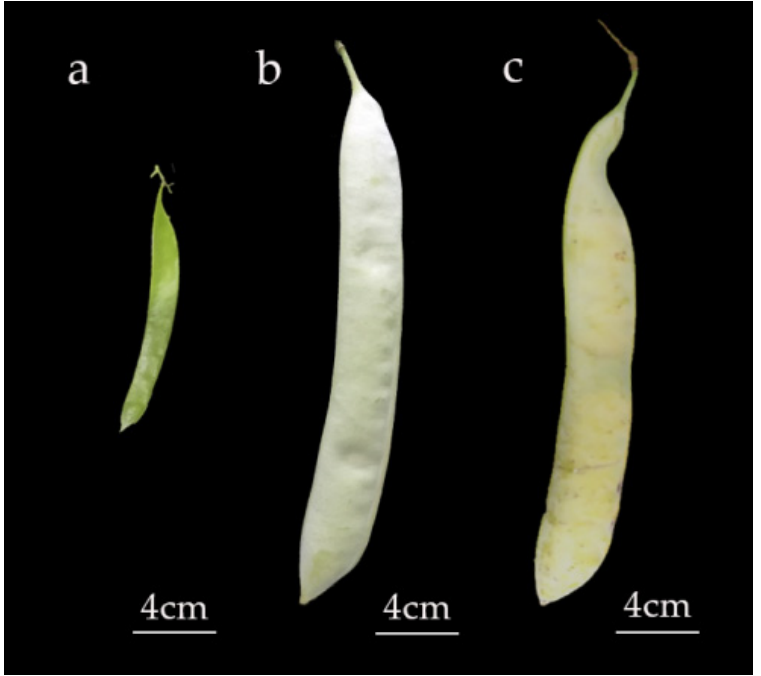
Figure 1. Gleditsia sinensis pods at the fruit-setting stage ( a ), elongation stage, ( b ) and browning stage ( c ).